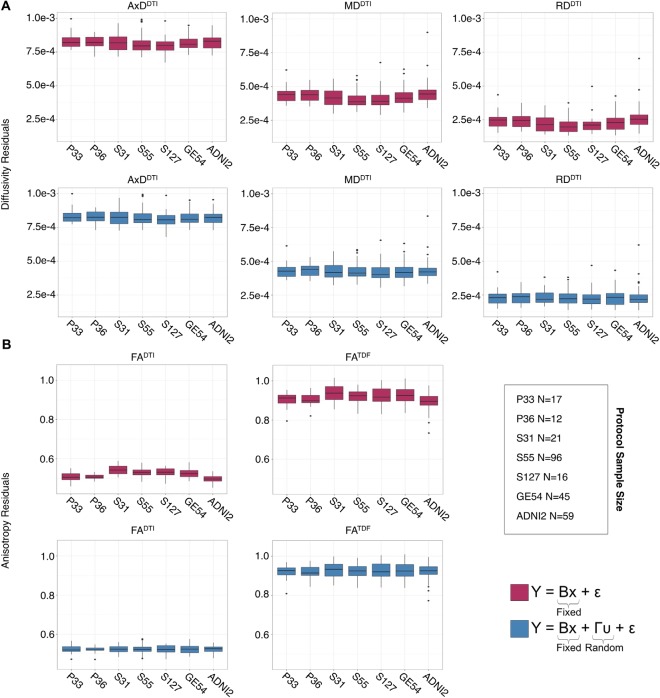
Full WM mean (A) AxDDTI, MDDTI, and RDDTI and (B) FADTI and FATDF residuals for each protocol, after fitting effects of age, sex, and age*sex interactions, are plotted here in the top rows (red). Protocol has an effect on anisotropy and diffusivity measures. The lower panels (blue) show residuals after additionally fitting protocol and site as nested random-effects, after which the residuals across protocols are closer to 0.